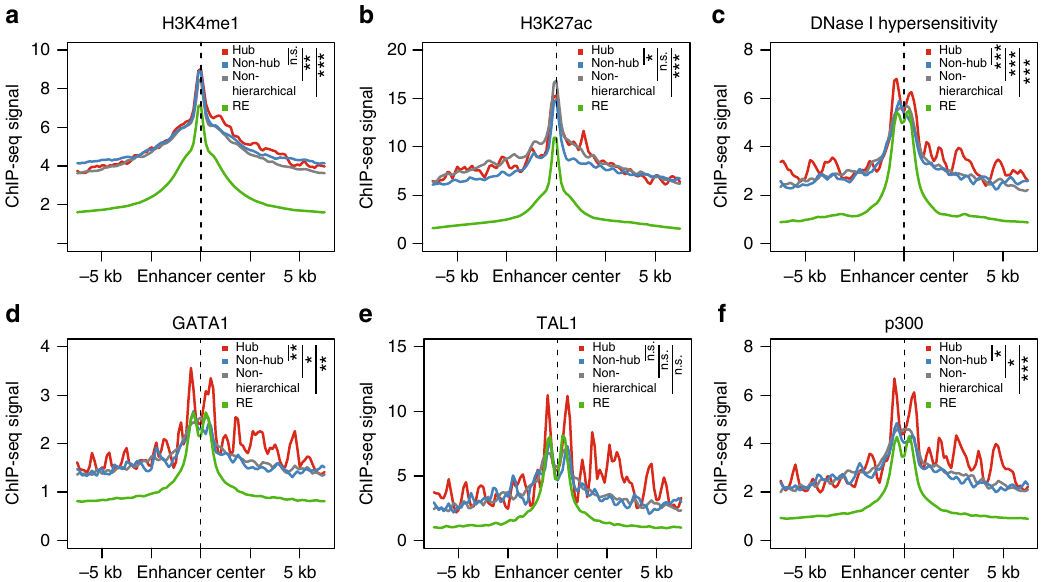
Fig. 2 Chromatin landscapes at hub enhancers in K562 cells. a – f Spatial distribution of chromatin marks centered by enhancers in four groups, hub ( n = 444), non-hub ( n = 2303) enhancers, enhancers in non-hierarchical SEs ( n = 4290) and regular enhancers ( n = 22477): H3K4me1 ( a ), H3K27ac ( b ), DNase I hypersensitivity ( c ), master regulators GATA1 ( d ) and TAL1 ( e ), coactivator p300 ( f ). P values were calculated using Student ’ s t -test based on the ChIP-seq signal intensity within 1 kb window centered by enhancers. *P < 0.05; **P < 0.01; ***P < 0.001, n.s. not signi fi